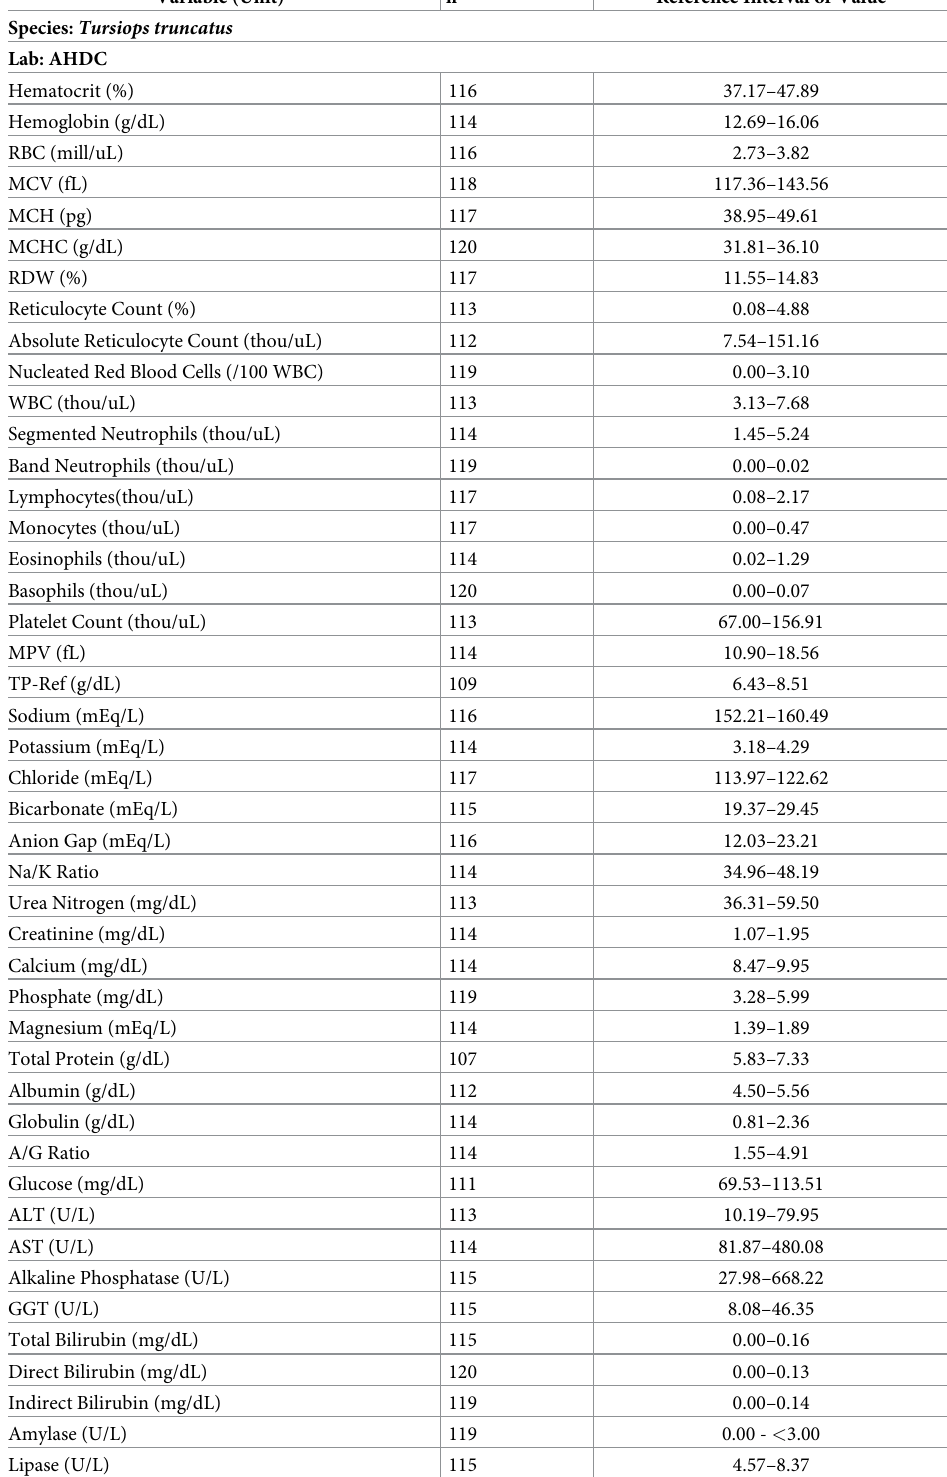
Table 4. General reference intervals and values for blood values for healthy